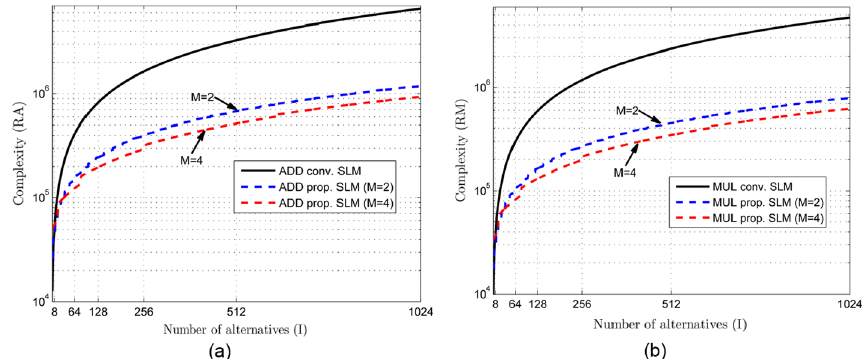
Fig. 8 Comparison of the computational complexity of conventional and proposed SLM techniques, in terms of ( a ) RA and ( b ) RM, for the same number of alternatives in two cases with M